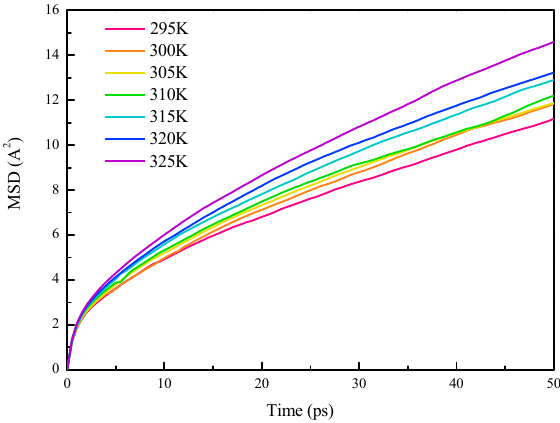
Figure 5. MSD of system (c) (1 Cu nanoparticle and 256 n -octadecane molecules) for different system temperatures.